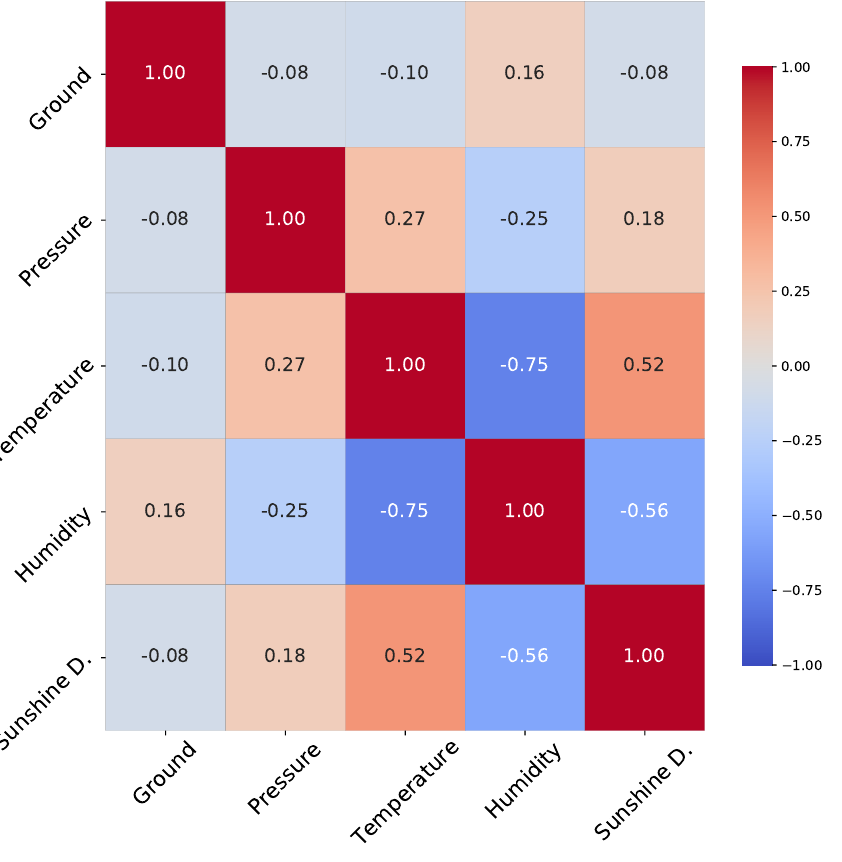
Figure 9. Correlation coefficient of different meteo-variables and ground precipitation calculated for the complete data set with 10-min time